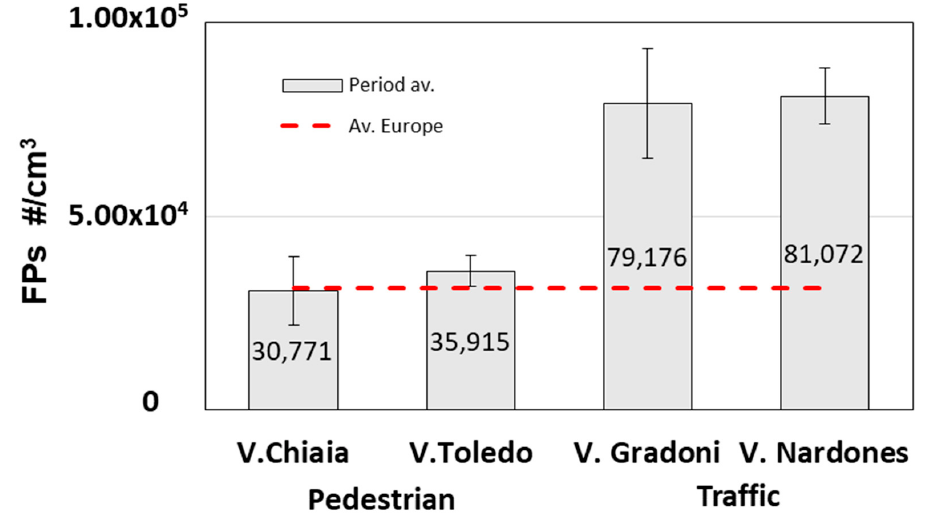
Figure 3. Period average concentration of fine particles (FPs) during the monitoring campaign for each of the four streets. Red dotted line is the average concentration in Europe [33].